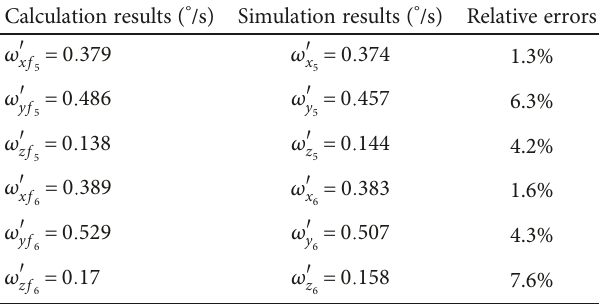
Table 24: Relative errors of calculation and simulation results for storage tank and microsatellite with the deployment ′ , ω ′ , and ω ′ y 5 z 5 5